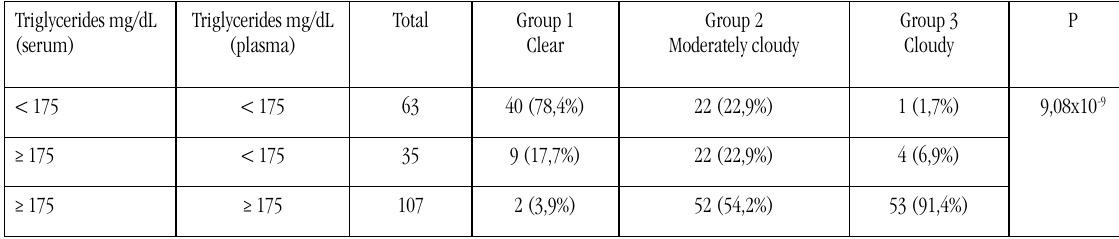
TABLE 2- Proportion of lipemic and non-lipemic serum/plasma considering the degree of lipemia and visual inspection Triglycerides mg/dL (serum)